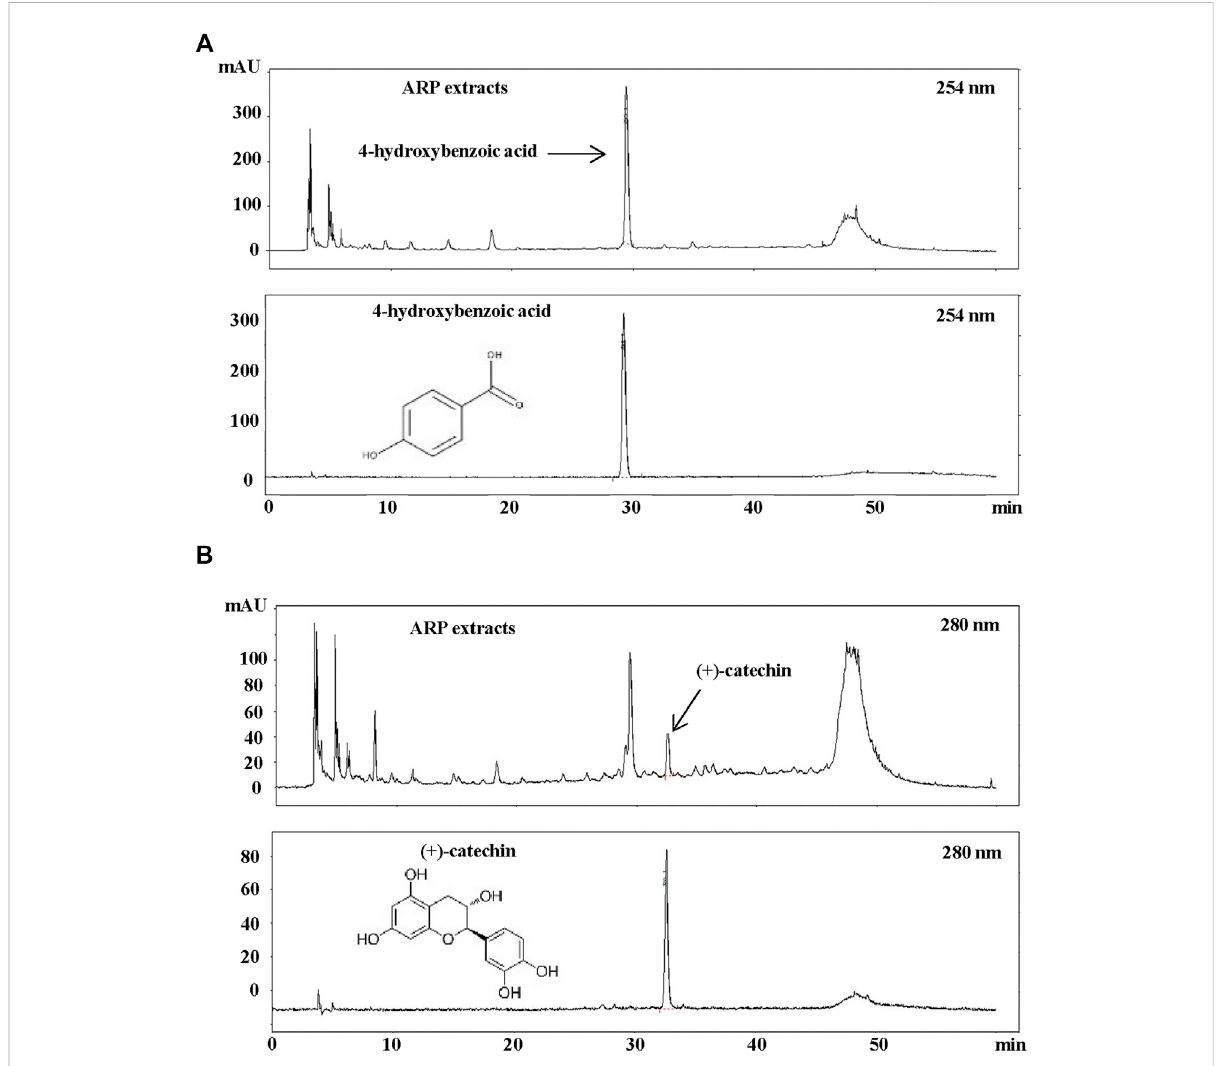
HPLC Analysis of ARP water extracts. ARP extract was dissolved in distilled water and fi ltered through a 0.45 μ m syringe fi lter. As standard, methanol-dissolved 4-hydroxybenzoic acid and (+)-catechin (99% purity) were used. A sample volume of 20 μ l was injected and analyzed at a fl